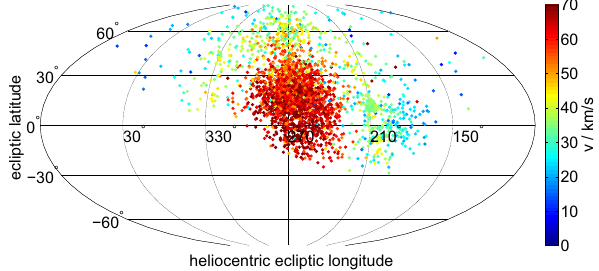
Fig. 8. Distribution of detected meteors in heliocentric coordinates with colour coded velocity.